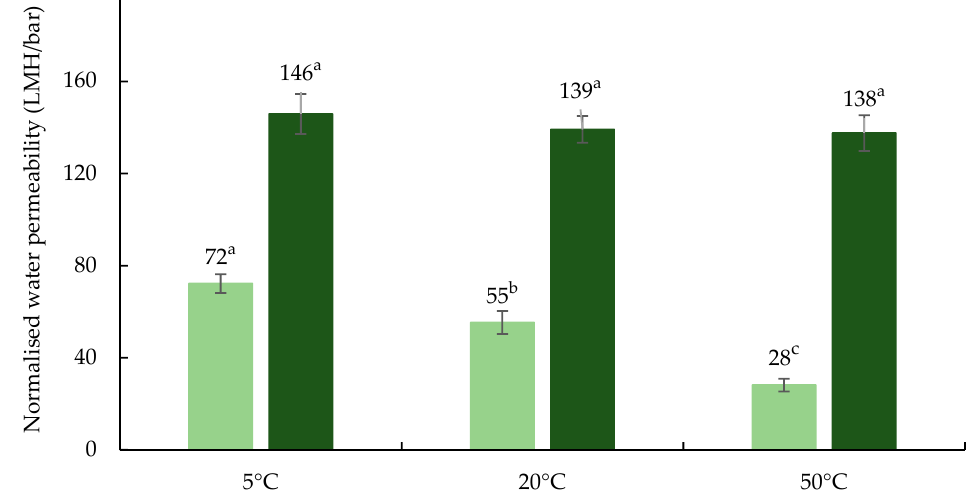
Figure 3. Normalised water permeability of membrane measured before ( ■ ) and after ( ■ ) membrane cleaning process. Values are the raw mean ± standard deviation of analysis from triplicate runs at each test temperature. Different superscripted lower-case alphabet letters within the bar graphs indicate significant differences ( p < 0.05). LMH: L/m 2 h.